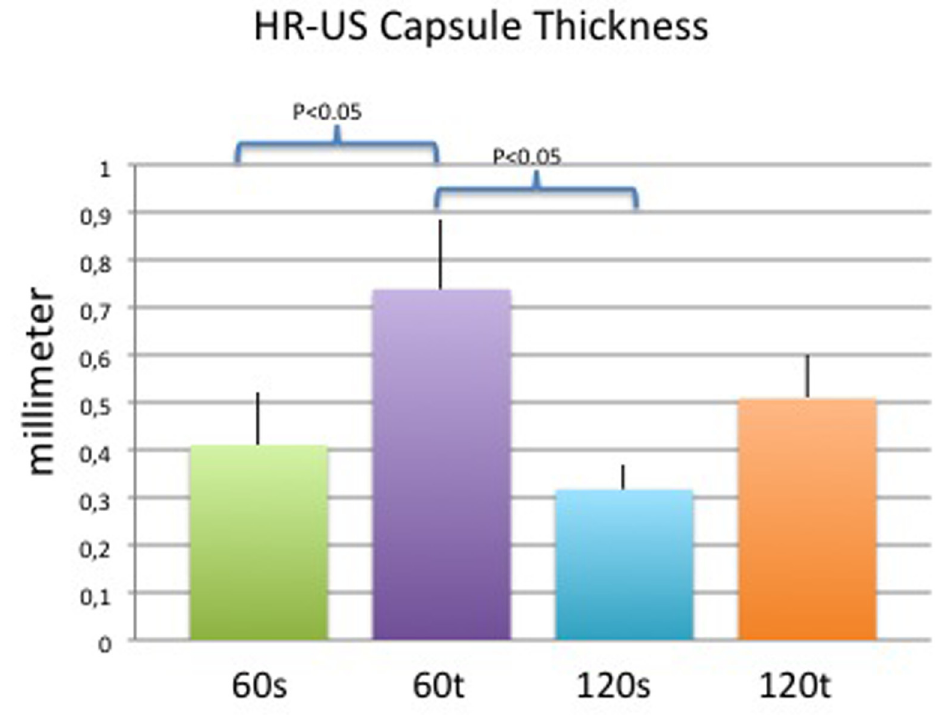
Fig 13. Mean (+/- standard deviation) capsule thickness measurements via high-resolution ultrasound of each study group. P < 0.05 was considered statistically significant.